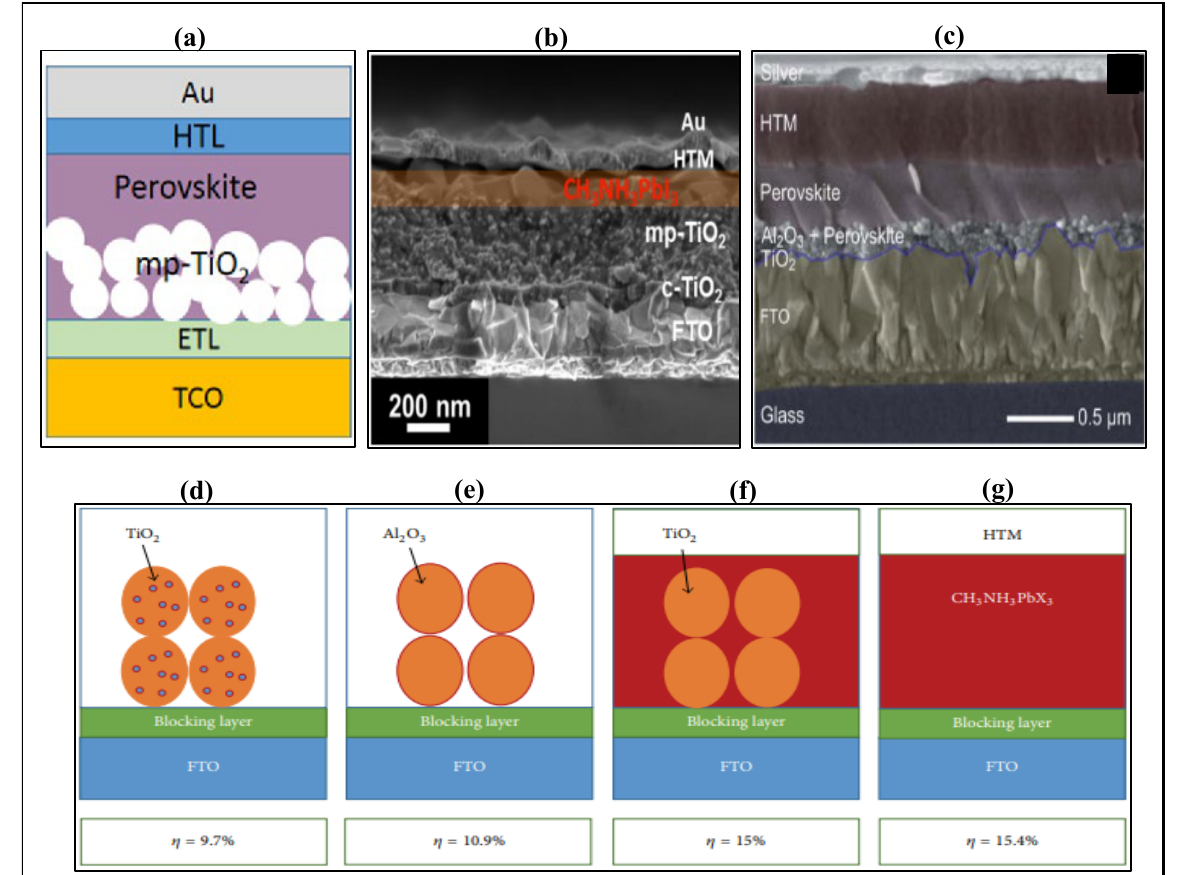
Figure 1. ( a ) Schematic representation of a solid-state perovskite sensitized device structure. SEM cross-sectional images of PSCs based on mesoporous ( b ) TiO 2 and ( c ) Al 2 O 3 . Progress in PSC efficiency with the cell structure: ( d ) sensitized PSC η = 9.7%, ( e ) mesoporous PSC η = 10.9%, ( f ) meso-superstructure PSC η = 15%, and ( g ) planar heterojunction thin-film PSC η = 15.4% [9,10,17,21].